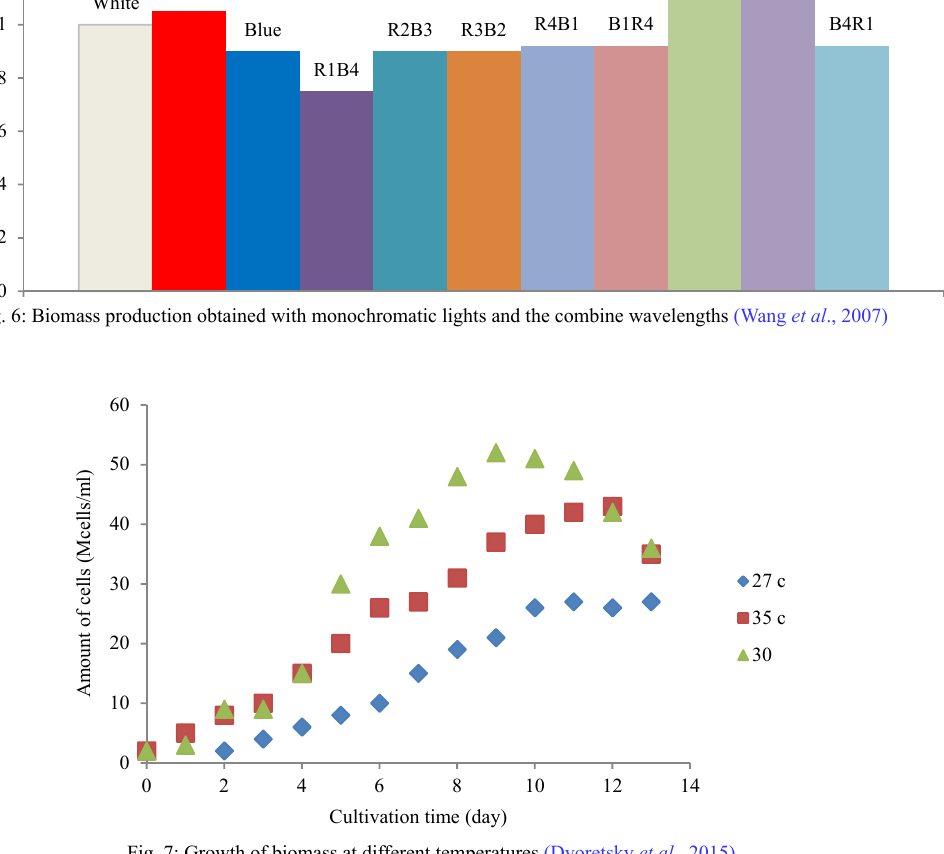
Fig. 7: Growth of biomass at different temperatures ( Dvoretsky et al ., 2015 )